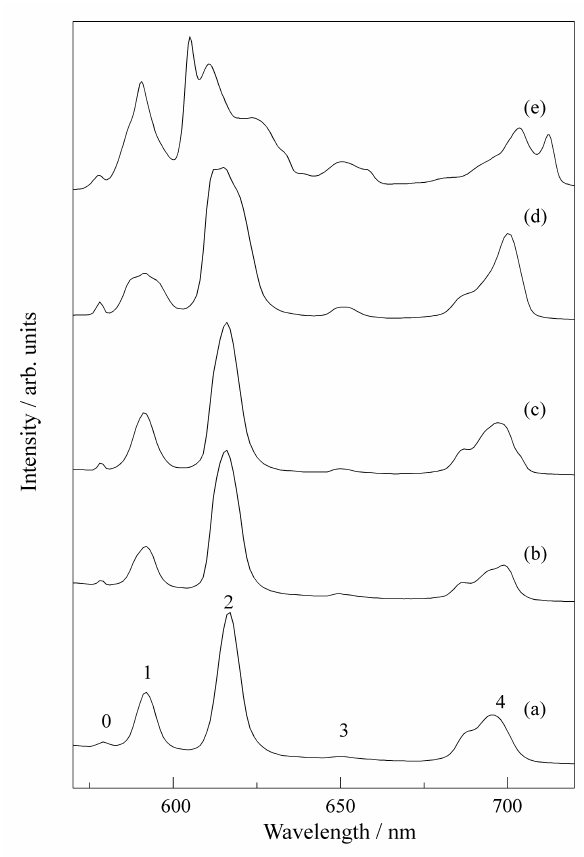
Figure 1. Eu 3+ 5 D 0 emission spectra in the ZrO 2 system (8% mol Eu 3+ ) under 5 L 6 excitation (395 nm). (a) Sol ( t ( 5 D 0 ) = 0.52 ms); (b) Wet gel ( t ( 5 D 0 ) = 0.52 ms); (c) Dried gel 50 °C ( t ( 5 D 0 ) = 0.52 ms); (d) Dried gel 130 °C ( t ( 5 D 0 ) = 0.84 ms) and (e) Xerogel 950 °C ( t ( 5 D 0 ) = 3.57 ms).The numbers refer to the J values of the final level of the emission transitions 5 D 7 F 0 fi J